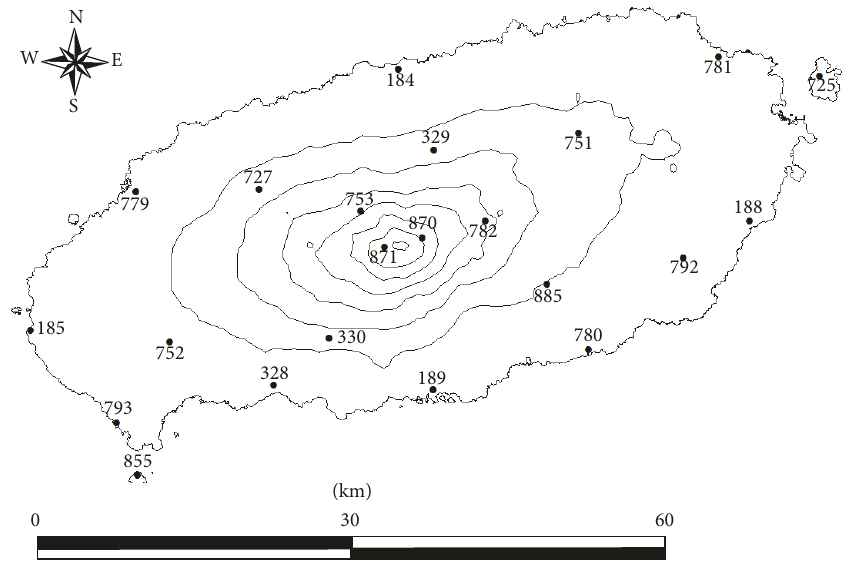
Figure 4: Rain gauges over the Jeju Island (184 (ID number), Jeju (place name), 185, Gosan, 188, Seongsan, 189, Seogwipo, 328, Jungmun, 329, Ara, 330, Hawon, 725, Udo, 727, Yusuam, 751, Seonheul, 752, Seogwang, 753, Eorimok, 779, Hallim, 780, Namwon, 781, Gujwa, 782,